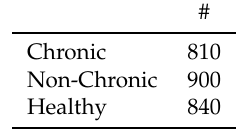
Table 2. Number of samples for each class after data augmentation.